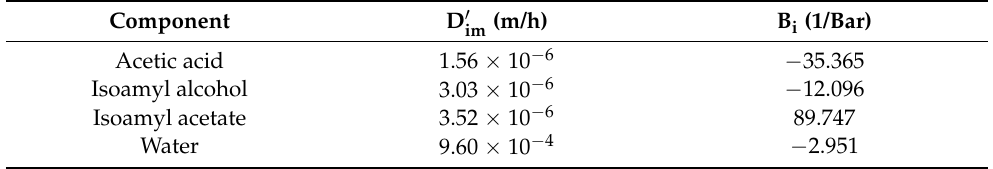
Table 2. Permeation model parameters of a hydrophilic silica membrane for the pervaporation of an acetic acid, isoamyl alcohol, isoamyl acetate, and water